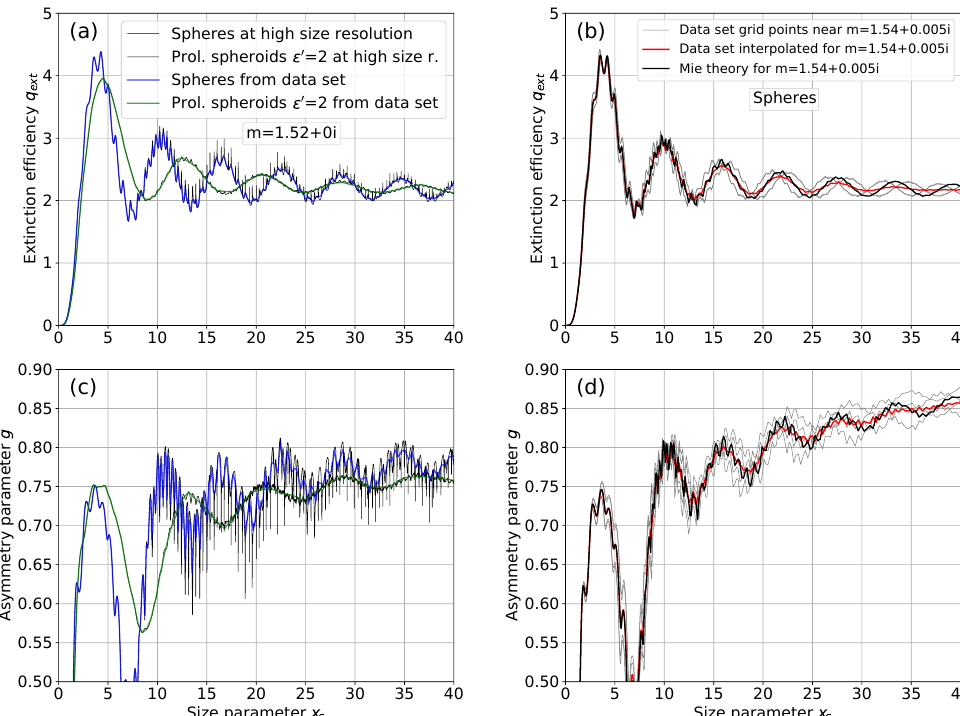
Figure 4. Examples illustrating the effect of the limited size resolution of the MOPSMAP data set (a, c) and the effect of the interpolation between the refractive index grid points of the data set (b, d) ; extinction efficiencies q ext (a, b) and asymmetry parameters g (c, d) as functions of the size parameter from x = 0 to x = 40 are compared; in (a) and (c) the high size-resolution calculations (black lines) were performed with linear x steps of 0.002 in the case of spheres and 0.01 in the case of spheroids; in (b) and (d) the red lines show properties calculated with MOPSMAP for m = 1 . 54 + 0 . 005 i by interpolation between refractive indices included in the data set (i.e., between m = 1 . 52 + 0 . 0043 i , m = 1 . 52 + 0 . 0060811 i , m = 1 . 56 + 0 . 0043 i , and m = 1 . 56 + 0 . 0060811 i , for which the properties are shown as thin gray lines), and for comparison, the black lines show the properties calculated by Mie theory explicitly for m = 1 . 54 + 0 . 005 i using the same x grid as used by the data set.